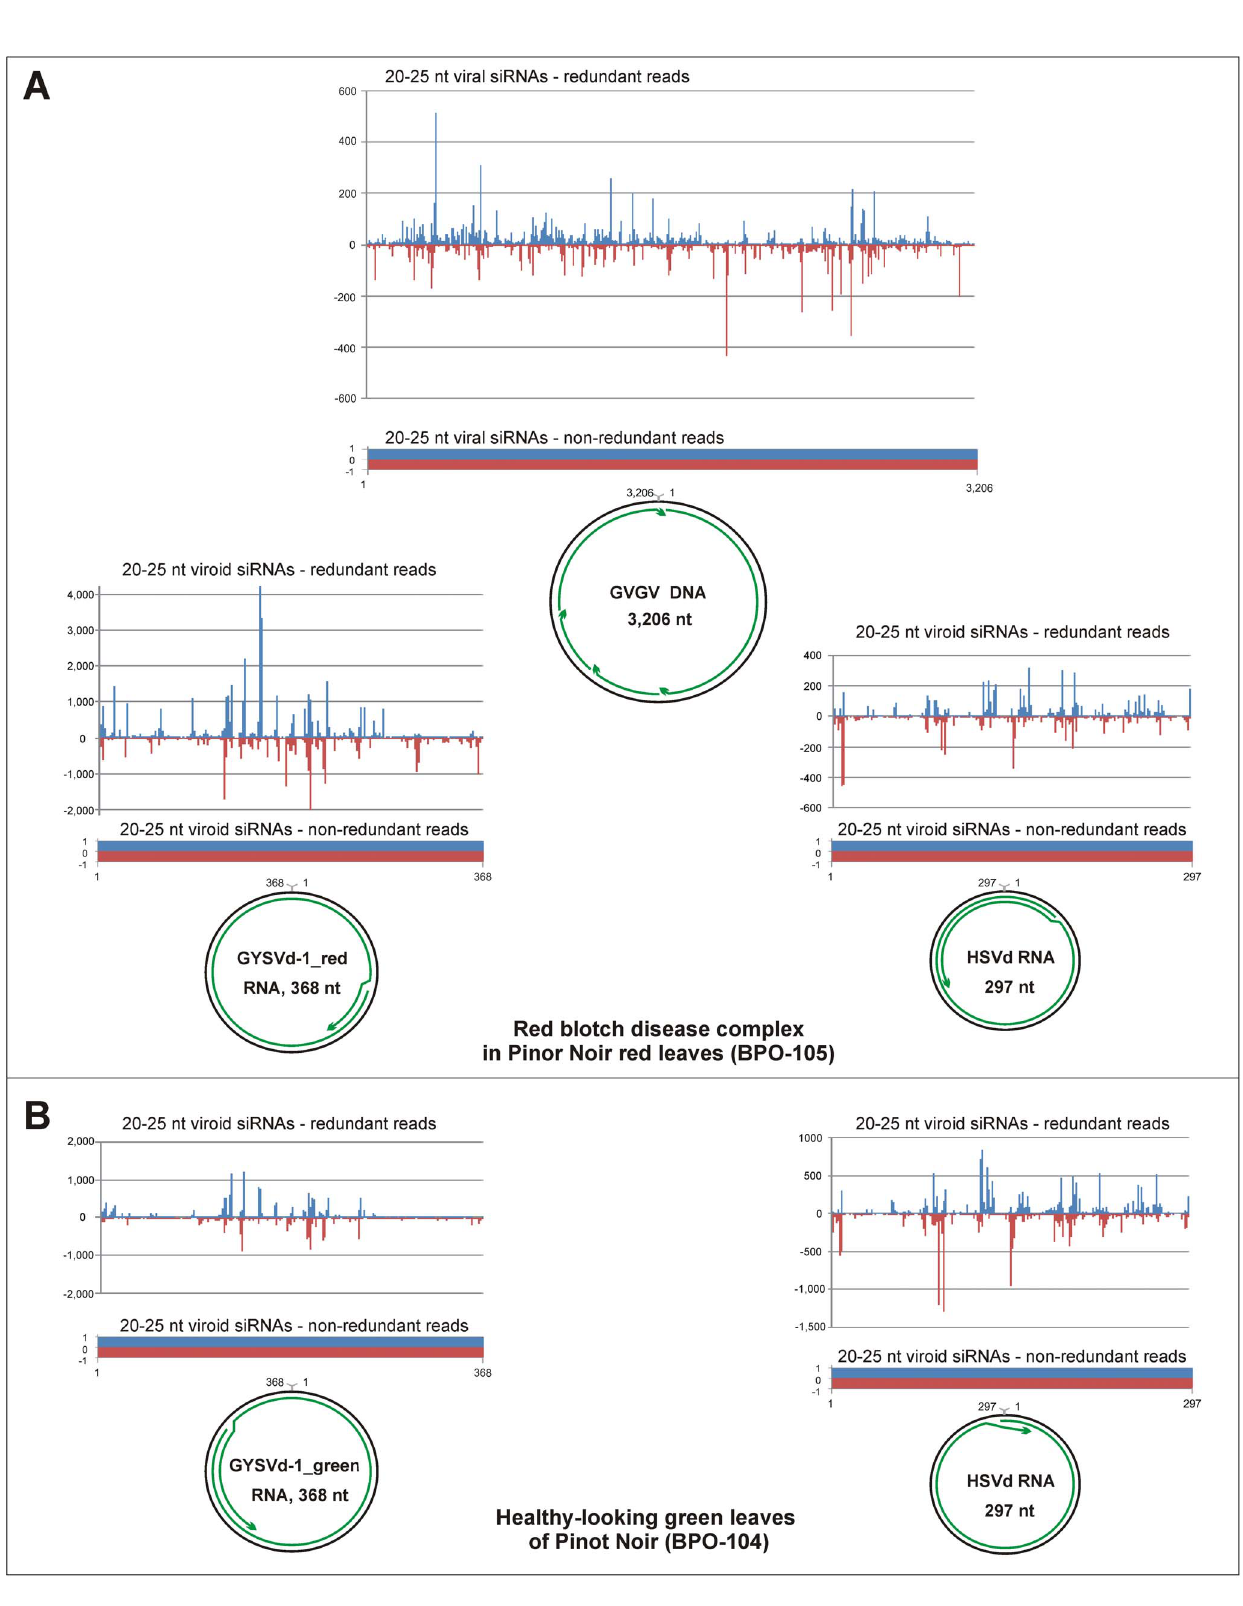
Figure 4. Maps of viral and viroid siRNAs and their contigs from red blotch disease-infected and healthy-looking leaves of grapevine. ( A ) Red blotch disease-infected leaves. ( B ) Healthy-looking green leaves. The graphs plot the number of 20–25 nt viral or viroid siRNA reads (redundant and non-redundant) at each nucleotide position of the genomes of the grapevine geminivirus (GVGV; also named GRBaV and GRLaV) and the viroids HSVd, GYSVd1_red and GYSVd1_green; Bars above the axis represent sense reads starting at respective positions; those below represent antisense reads ending at respective positions. The circular DNA genome of GVGV and the circular RNA genomes of HSVd, GYSVd1_red and